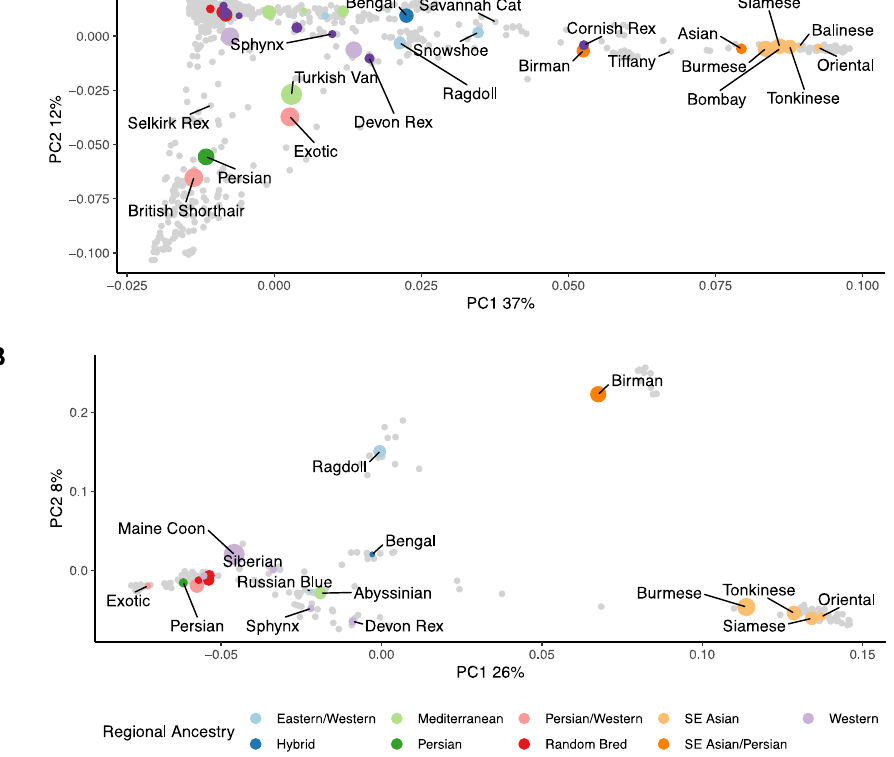
Figure 1. Principal component analysis (PCA). ( A ) PCA analysis for all 1290 samples. ( B ) PCA analysis for all samples in the balanced dataset. A subset of breeds is labelled to avoid overplotting.